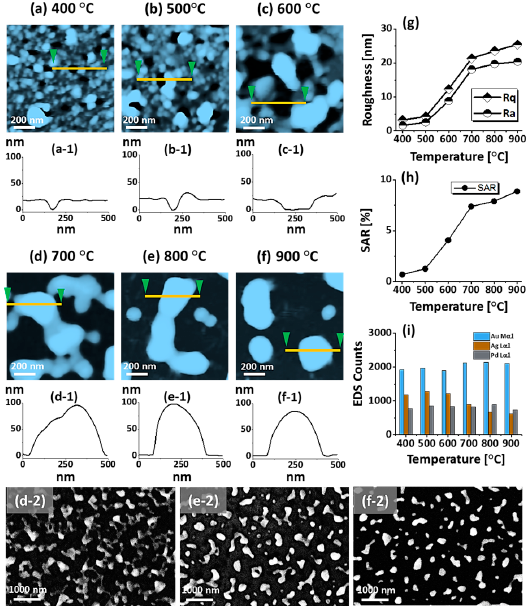
Figure 2. Formation of self-assembled ternary AuAgPd alloy NPs. ( a – f ) AFM top-views of 1 × 1 µm 2 show the gradual evolution of voids, nanoclusters and nanoparticles (NPs) between 400 and 900 °C for 450 s. ( a - 1 – f - 1 ) Cross-sectional line profiles based on the line in AFM top-views. Summary plot of ( g ) roughness, ( h ) surface area ratio (SAR) and ( i ) energy dispersive x -ray spectroscope (EDS) counts with respect to the annealing temperature. ( d - 2 – f - 2 ) Scanning electron microscope (SEM) images of alloy NPs between 700 and 900 ◦